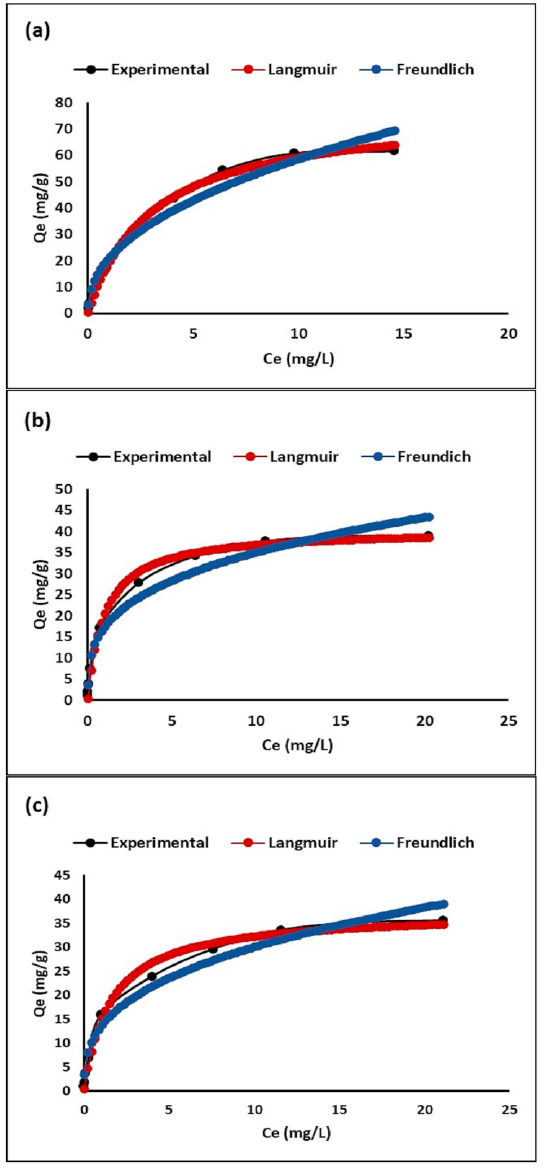
Figure 7. Adsorption isotherm of ( a ) DE, ( b ) ZTO/La-DE, and ( c )